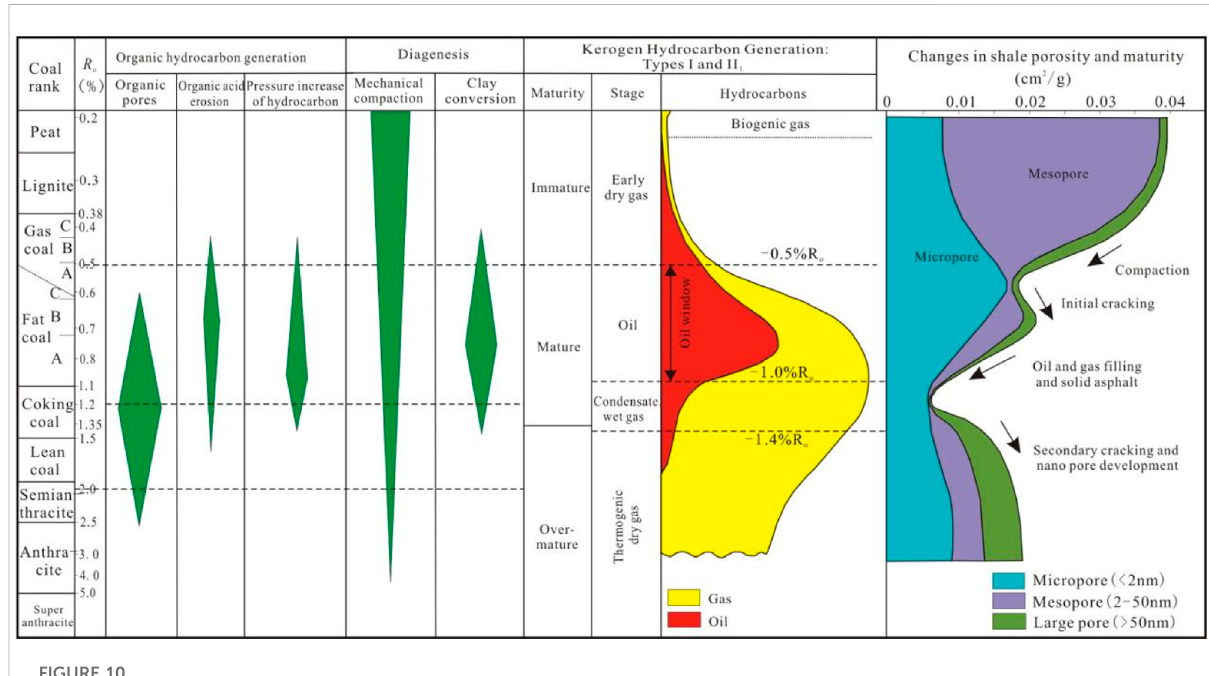
FIGURE 10 Evolution mode of pores in the Chang 7 Member shale in Yan ’ an